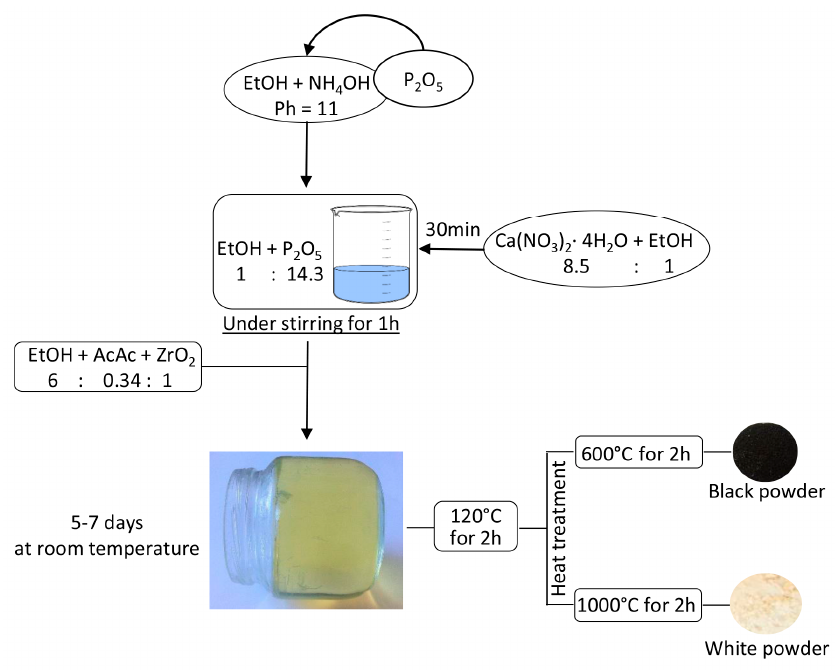
Figure 11. Flow chart of the sol-gel synthesis and heat treatments.